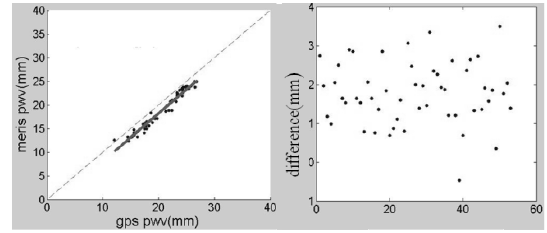
Figure3. temporal and spatial distribution comparison of MODIS PWV and GPS PWV